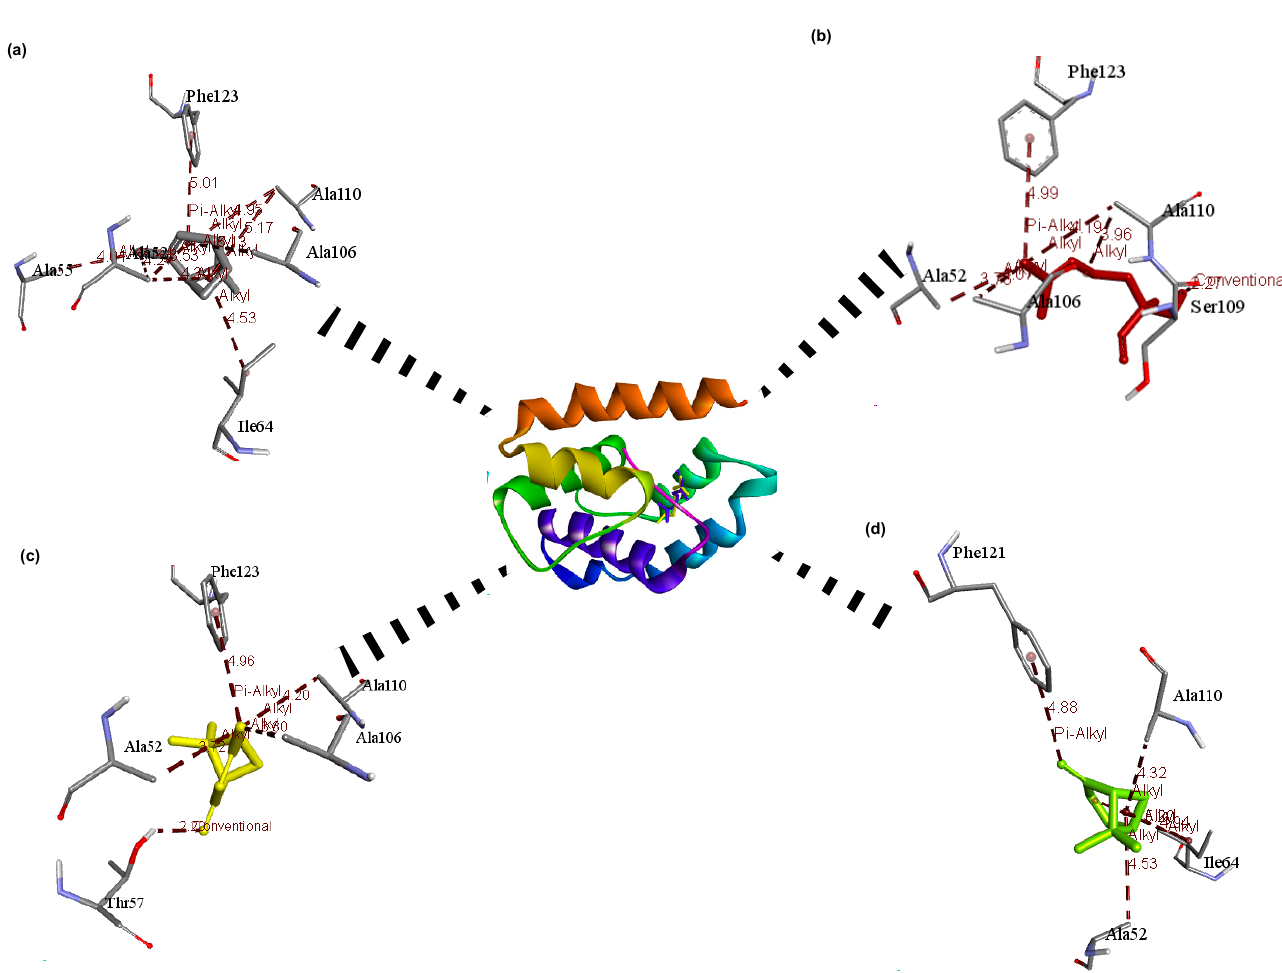
Figure 14. 3D interactions showing the selected ligands: ( a ) α -pinene, ( b ) linalool, ( c ) verbenone, and ( d ) β -pinene with the most interaction at the active sites of the OBP4. Table 7. The number and type of bonds for the OBD–ligand complexes. Interacting Amino Acids in the Active